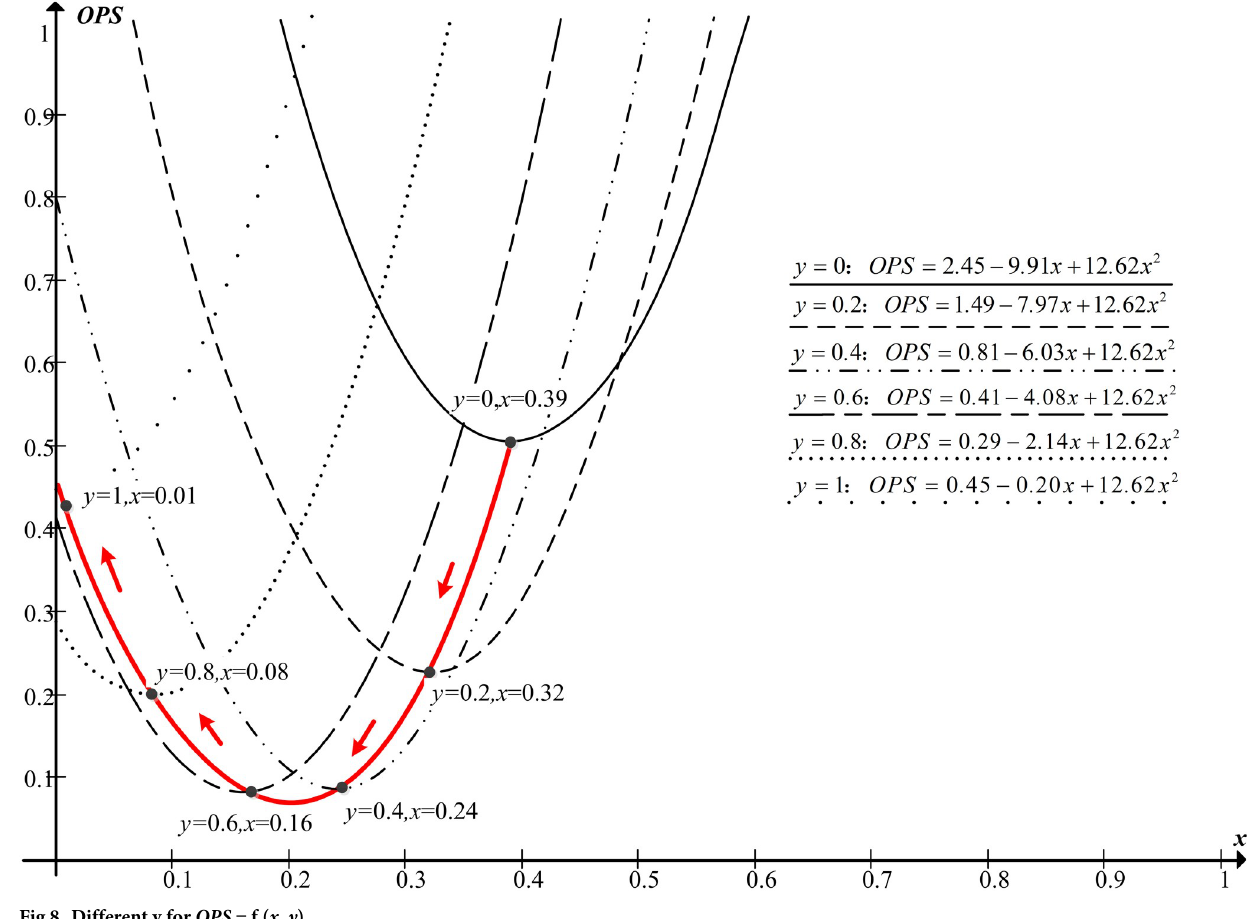
Fig 8. Different y for OPS = f ( x , y